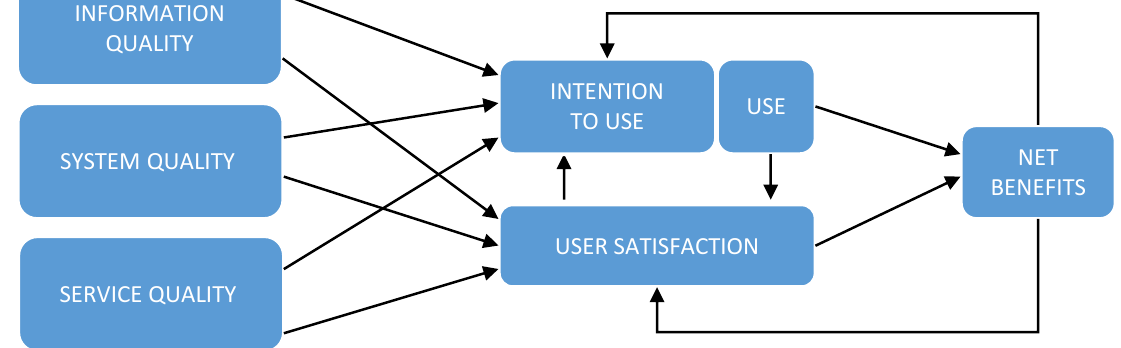
Figure 1. DeLone and McLean (2003) updated IS success